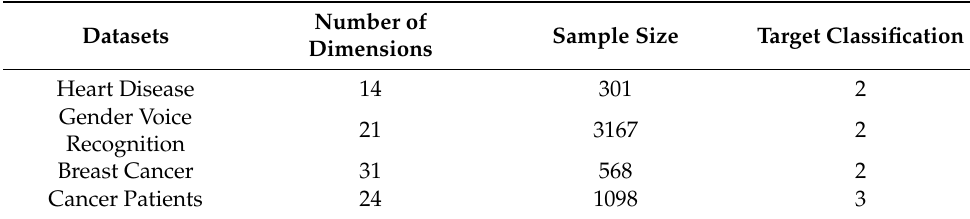
Table 4. Datasets used and their